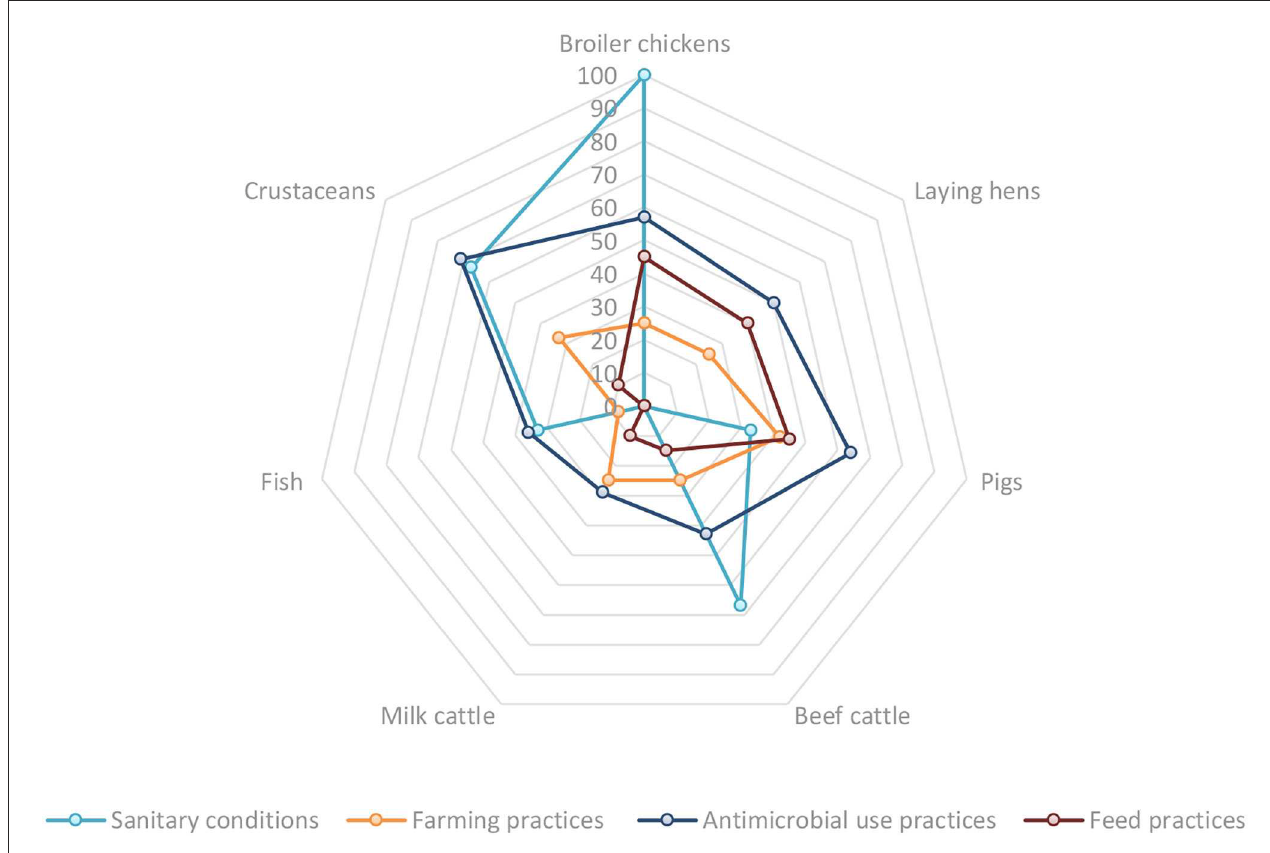
FIGURE5 Comparative percentages of subfactors that present risks based on the qualitative risk assessment for human health, by introduction risk factor and animal production